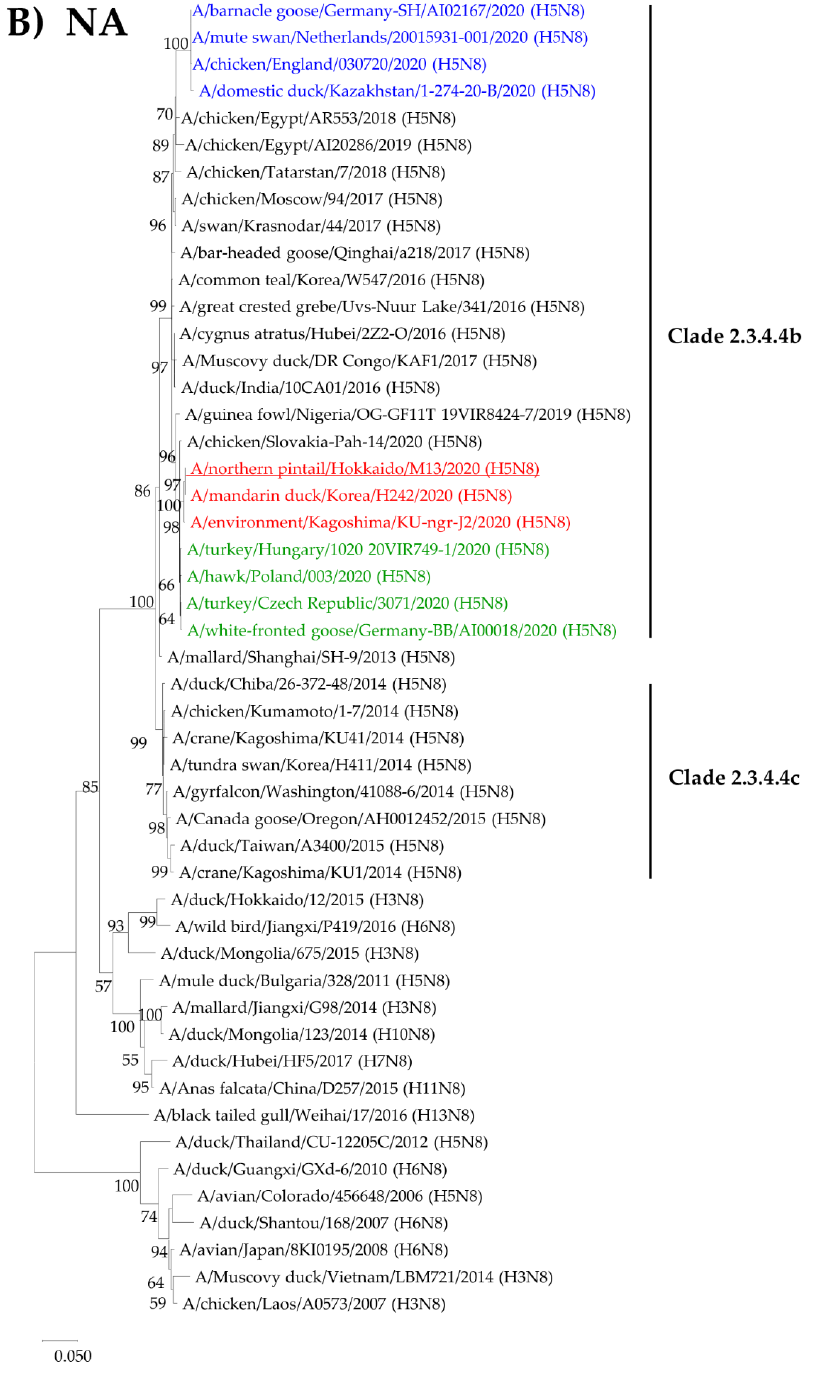
Figure 2 . Phylogenetic tree analysis on the hemagglutinin (HA) and neuraminidase (NA) gene segments. Phylogenetic tree analysis was based on ( A ) the HA gene segment containing a total of 67 H5 clade 2.3.4.4, other clades, and outgroups, and ( B ) the NA gene segment containing a total of 49 N8 NA, including highly and low pathogenic avian influenza viruses. The red-colored strain indicates H5N8 high pathogenicity avian influenza viruses (HPAIVs) isolated in Japan and Korea, 2000 of which A/northern pintail/Hokkaido/M13/2020 (H5M8), an isolate in Hokkaido, 2020 is underlined. The green-, yellow-, and blue-colored strains indicate the H5N8 HPAIVs isolated in Europe in the winter of 2019-2020, H5N6 HPAIVs isolated in Japan and Korea in the winter season of 2017 – 2018, and H5Nx HPAIVs isolated in Europe in October and November, 2020, respectively. The numbers below or above the node indicate bootstrap values greater than